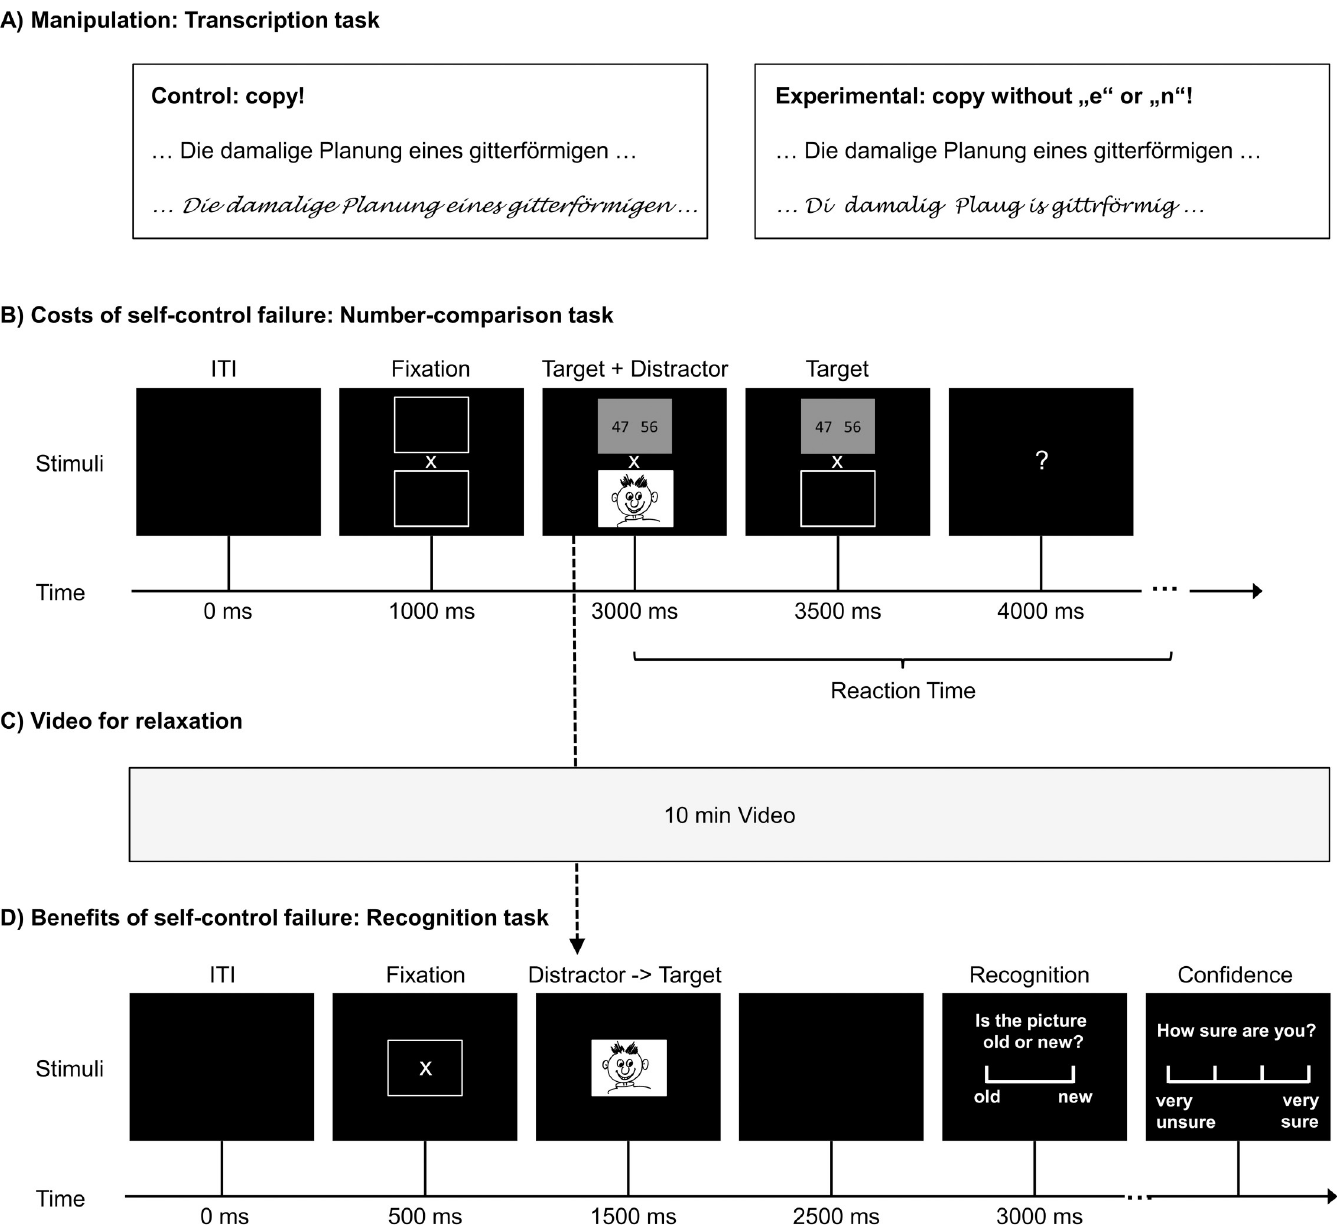
Fig 1. Tasks. A) The first task was used to manipulate the amount of effortful self-control that participants had to exert. In this transcription task, participants were asked to copy a text either omitting the frequent letters “e” and “n” (experimental) or as usual (control). B) The second task was used to measure the costs of self-control failure. Participants of both groups were asked to work on a number-comparison task and to ignore the pictures. Participants had to indicate whether the left or right of the two- digit numbers was bigger. The distracting photographic pictures either showed reward-related stimuli (e.g. chocolate cake) or matched neutral stimuli (e.g. grey bread). C) To introduce a delay between incidental memory encoding and recognition task as well as to allow the participants to recover from the previous effortful tasks, a 10 min long video about abstract painting was shown and the participants were instructed to watch and relax. D) The third task was used to measure the hidden benefits of self-control failure. In an unannounced recognition task, participants were asked whether they had seen the pictures before and how confident they were about their judgment. One-half of the pictures were “distractors” from the second task and the other half new pictures, i.e. former distractors became targets. A shift of the attention from the number-comparison task to the distracting pictures would result in better recognition performance later